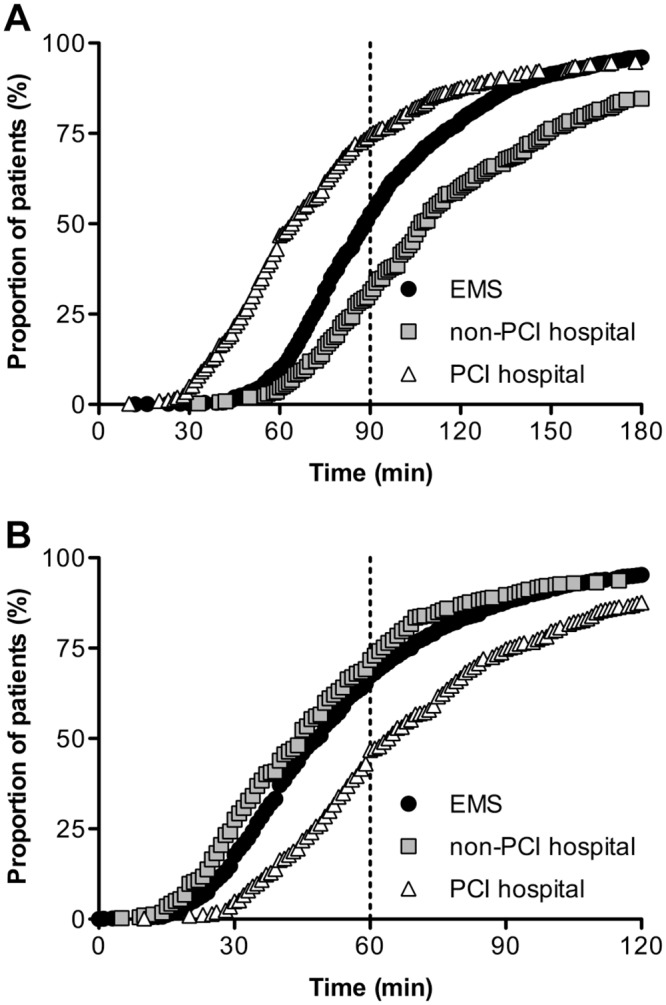
Cumulative frequency distribution of critical time intervals by type of first medical contact.(A) Proportion of patients who were treated within certain contact-to-balloon times with guideline-recommended target time of 90 minutes highlighted with dashed line. (B) Proportion of patients who were treated within certain door-to-balloon times with guideline-recommended target time of 60 minutes highlighted with dashed line. EMS indicates emergency medical services, PCI indicates percutaneous coronary intervention.